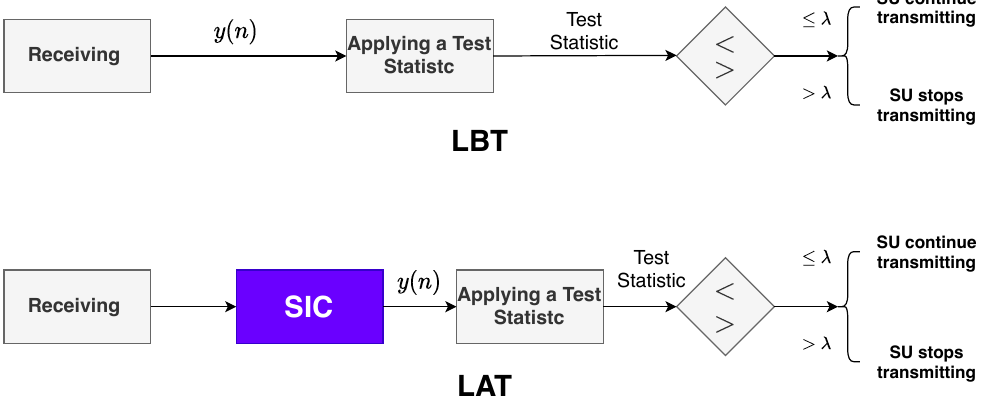
Figure 3. Spectrum Sensing processes under LBT and LAT. For LBT, no Self-Interference Cancellation (SIC) module is required since there is no simultaneous Transmit-Sense (TS), and the Test Statistic may be directly applied to the received signal. By contrast, SIC is applied before evaluating the Test Statistic in LBT to reduce the effect of SI on the Spectrum Sensing (SS)